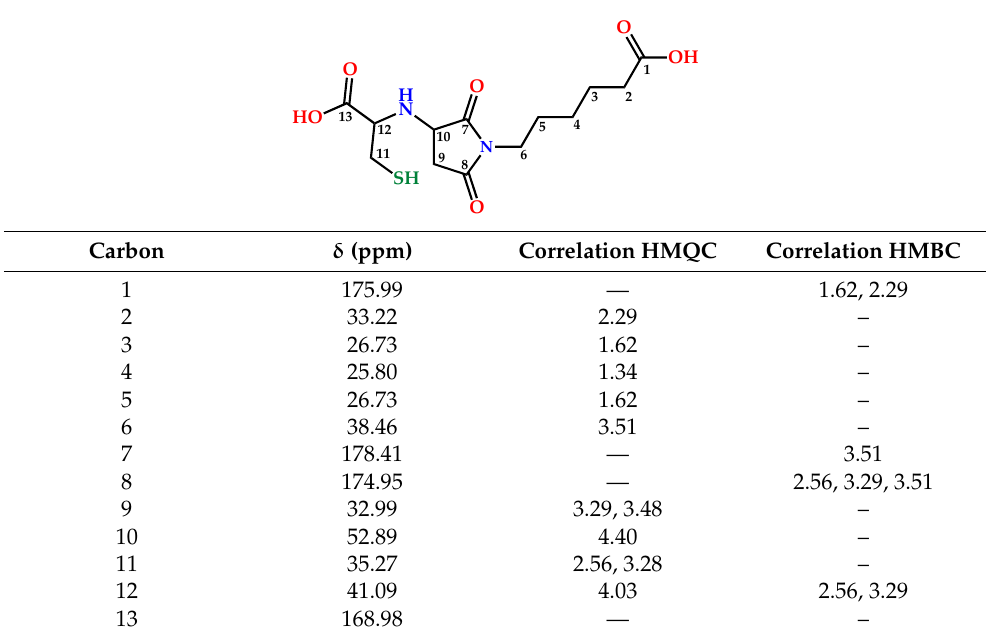
Figure 4. Comparison of NMR spectra in DMSO -d 6 , for mixtures of products and individual adducts. Table 1. Correlations for Compound 2 .